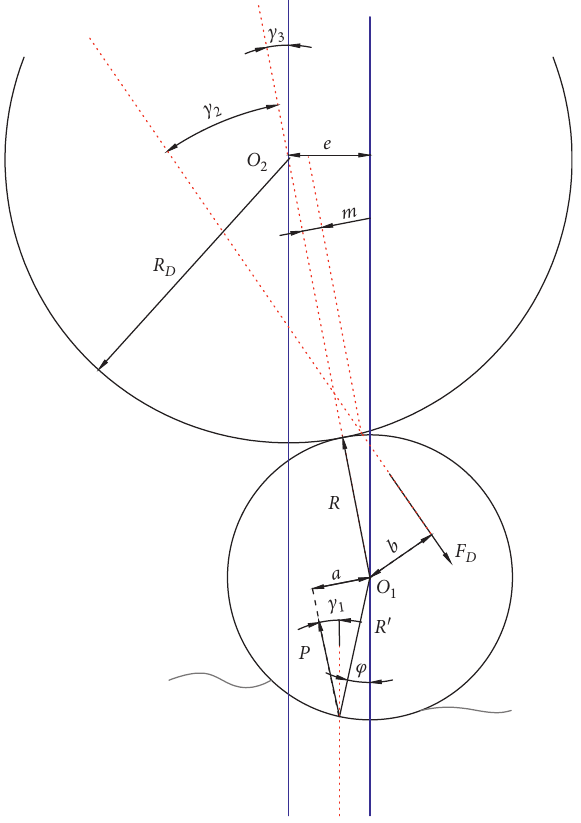
Figure 2: Force of backup roll on work